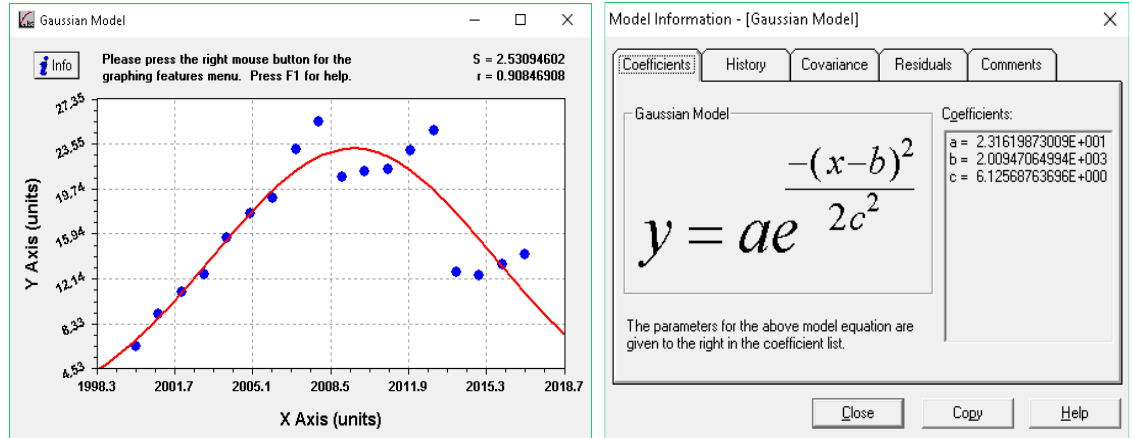
Figure 3. High rank model – Gaussian Model and information about it